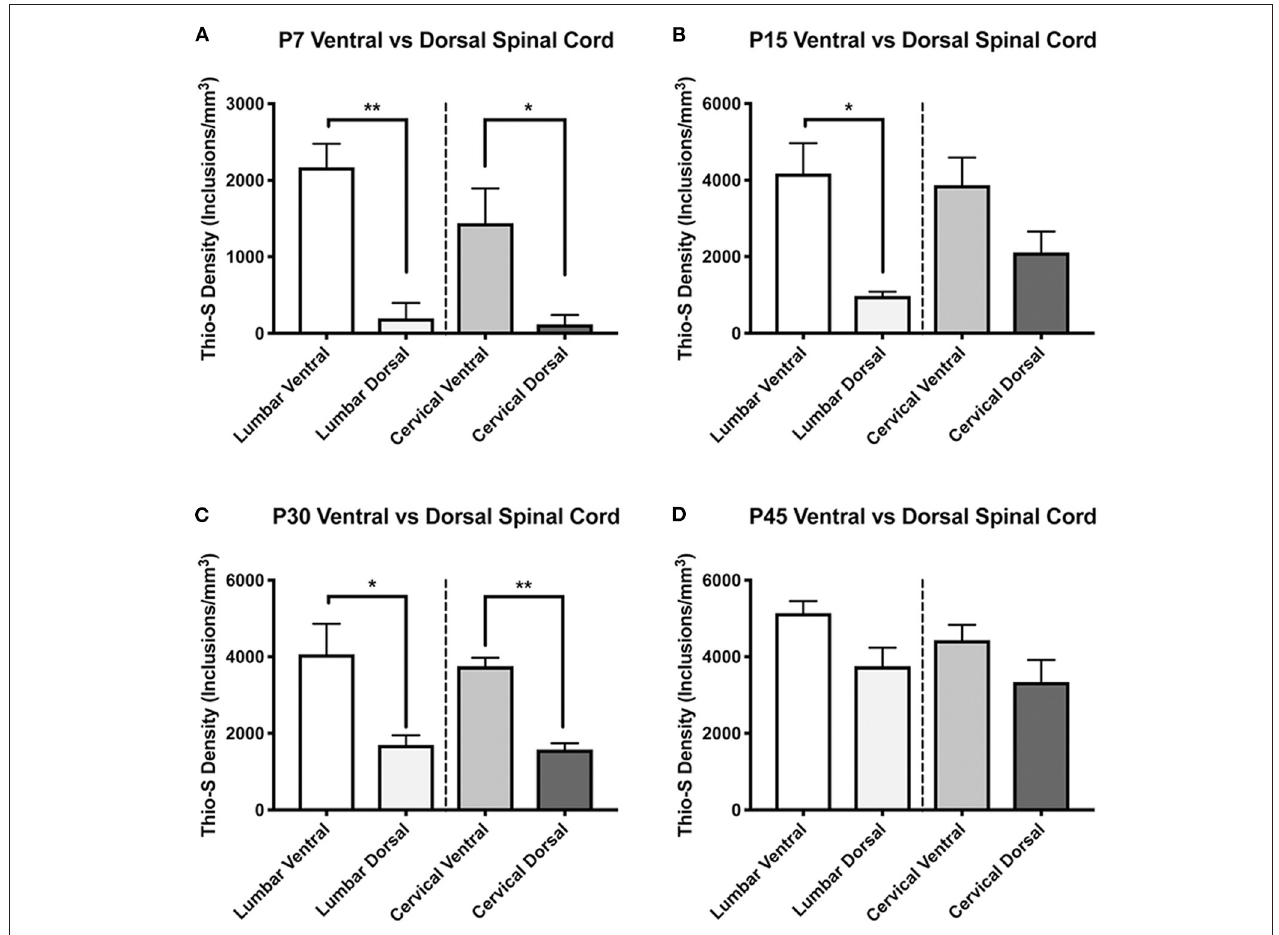
FIGURE 2 | Thioflavin-S quantification and comparison between ventral and dorsal spinal cords across life-span. Stereological analysis was performed to quantify thioflavin-S (thio-S) accumulation and compare thio-S density (inclusions/mm 3 ) between ventral and dorsal spinal cord (A–D) . Significantly more thio-S inclusions were observed in the ventral cord as compared to the dorsal at all timepoints (A–C) expect post-natal day 45 (P45) (D) . Significance between means analyzed by ANOVA and Tukey’s post-hoc analysis with (*) indicating p < 0.05, (**) p < 0.01. n = 3–4 animals. Results are presented as mean ± error of the